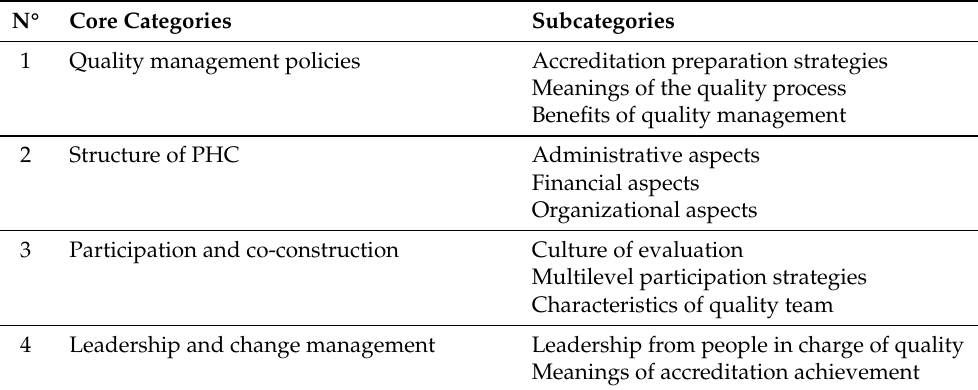
Table 2. Categories and